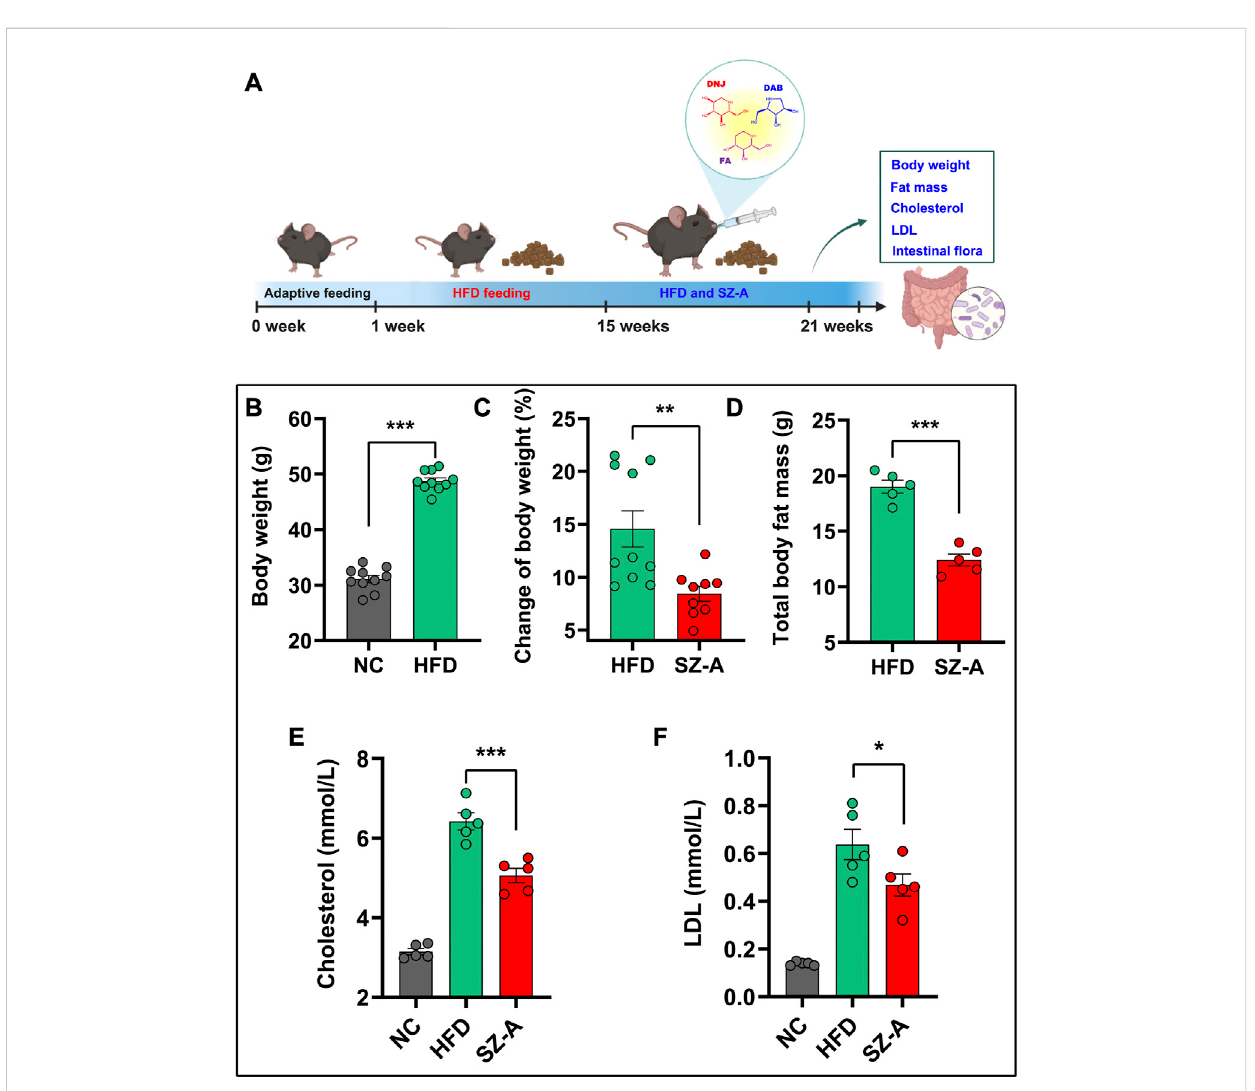
FIGURE 1 SZ-A slowed weight gain in obese mice induced by HFD. (A) The fl ow chart of relieving weight gain in obese mice by oral administration of SZ-A. In thisexperiment,C57BL/6Jmice werefedahigh-fatdietfor 14 weeks and then orallyadministered SZ-A(200 mg/kg/day)daily for 6 weeks. (B) TheBody weight of mice fed with a maintenance diet (NC) or HFD ( n = 10). (C) The change of body weight of mice treated with SZ-A (200 mg/kg) ( n = 9 – 10). (D) Total fat mass of mice treated with SZ-A (200 mg/kg) ( n = 5). (E) Effect of SZ-A (200 mg/kg) on serum level of cholesterol ( n = 5). (F) Effect of SZ-A (200 mg/kg) on serum level of LDL ( n = 5). Each value is expressed as mean ± SEM. *** p < 0.001, ** p < 0.01. * p <